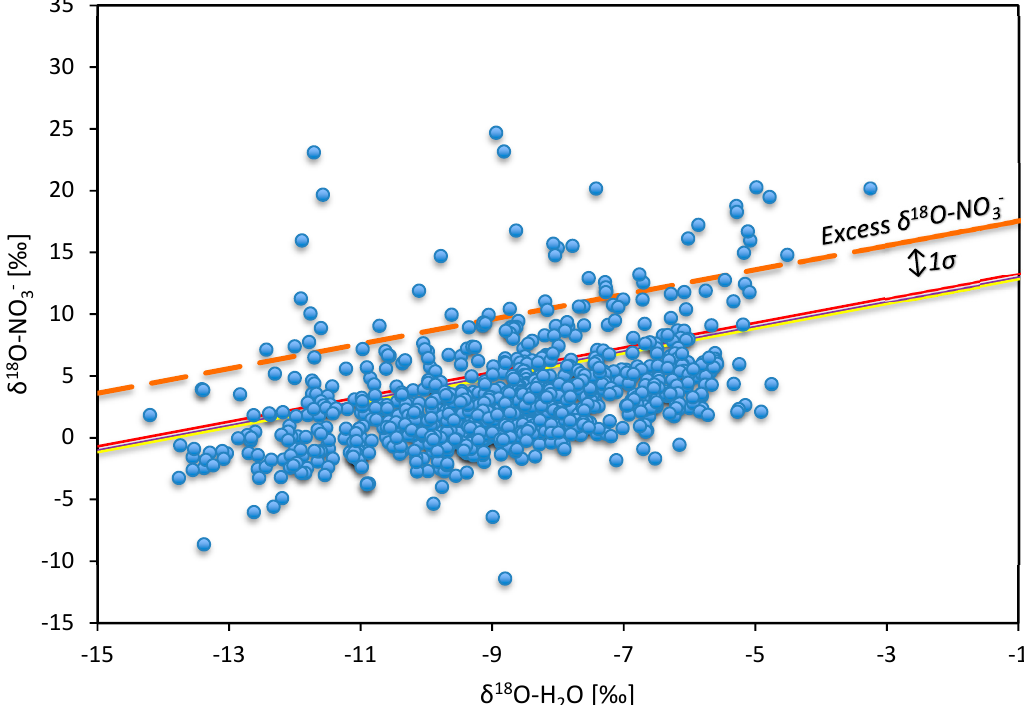
Figure 6. δ 18 O-H 2 O vs. δ 18 O-NO 3 − with lines showing predicted values following Equation (1) of Snider et al., 2010. Three separate lines are shown, tightly grouped, using differing values of abiotic exchange ( f abiotic ). The orange line labeled ‘Excess‘ is 1 σ above the line using f abiotic = 0.52.